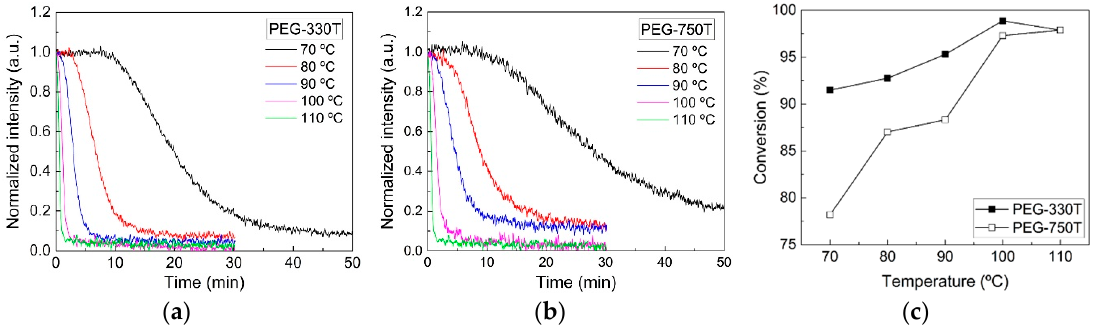
Figure 4. Transient intensity changes of ( a ) PEG-330T and ( b ) PEG-750T mixtures during thermal curing under different temperature conditions. ( c ) Changes in the conversion value for the two hydrogel mixtures.